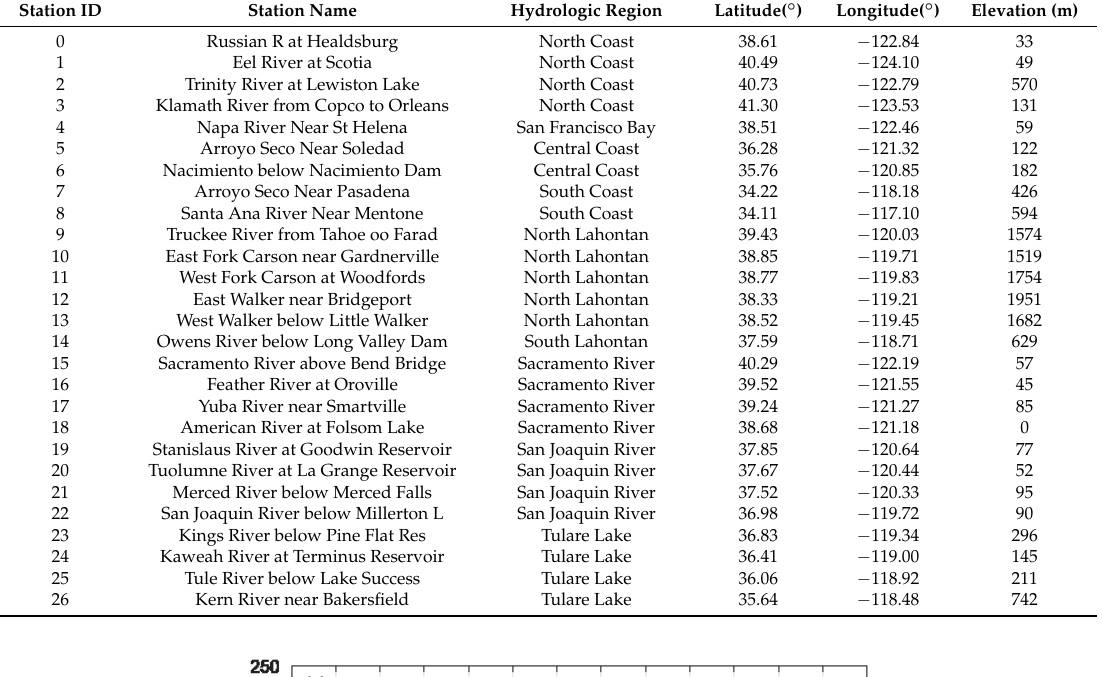
Table A2. Streamflow gauges applied in determining runoff indices and water supply indices.